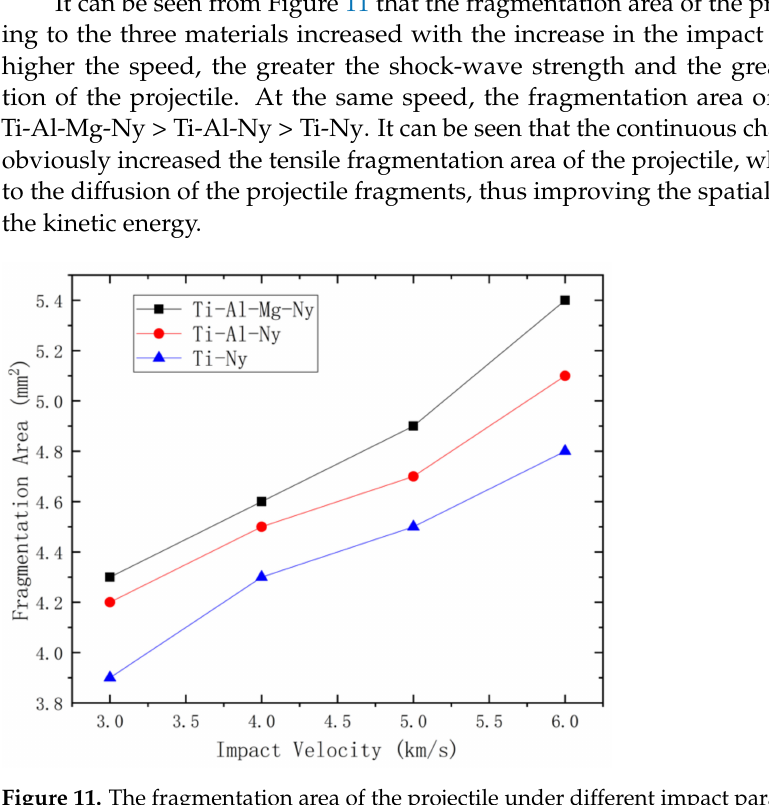
Figure 11. The fragmentation area of the projectile under different impact